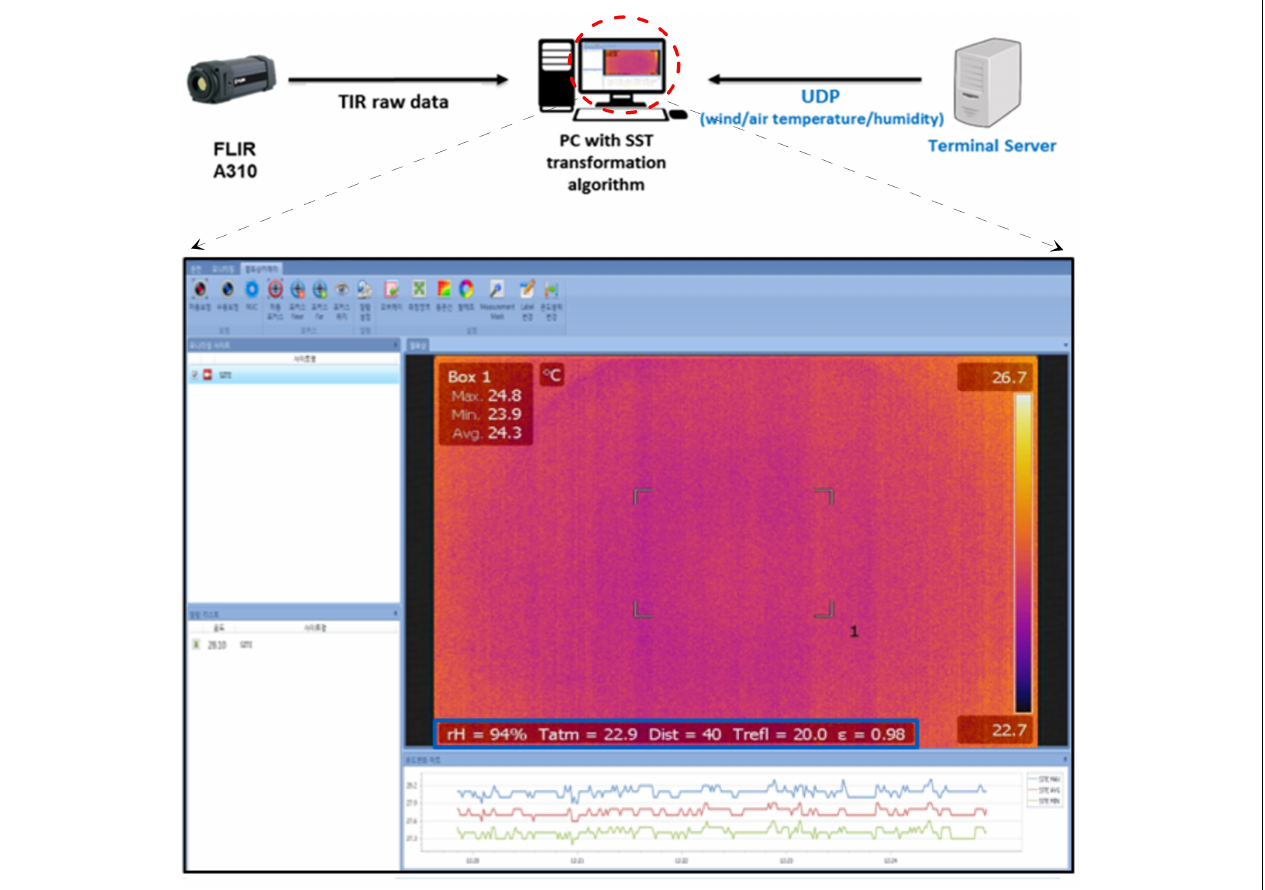
FIGURE 5 | Thermal infrared (TIR) based sea surface temperature measurement system operated at Ieodo ORS by Korea Hydrographic and Oceanographic Agency. The TIR system’s image displays input values [relative humidity (rH, %); air temperature (Tatm, ◦ C); distance to sea surface (Dist, m); reflected ambient temperature (Trefl, ◦ C); and emissivity ( ε ) estimated by wind speed and direction] used for real-time atmospheric